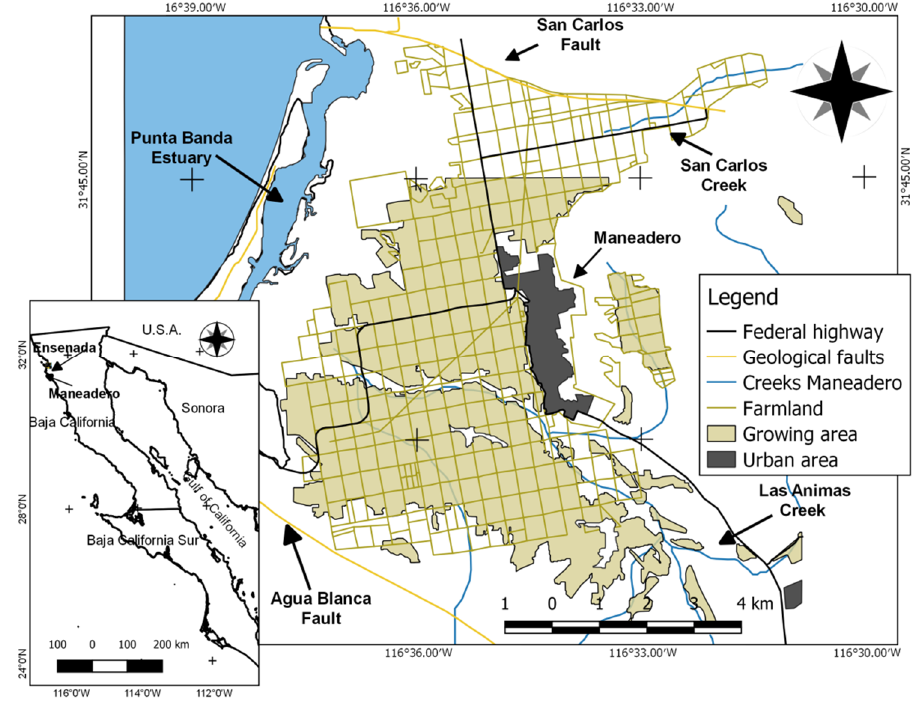
Figure 1. Localization of Maneadero Valley in Ensenada, Baja California.